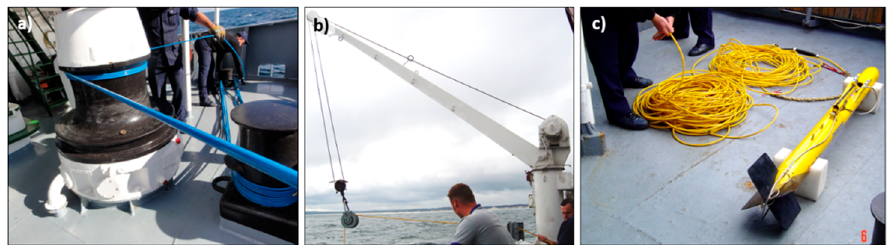
Figure 26. Deck equipment used for sonar towing operations in the absence of a cable winch and A-frame: ( a ) use of mooring capstan; ( b ) use of transport davit; ( c ) laying sonar cable on the deck.